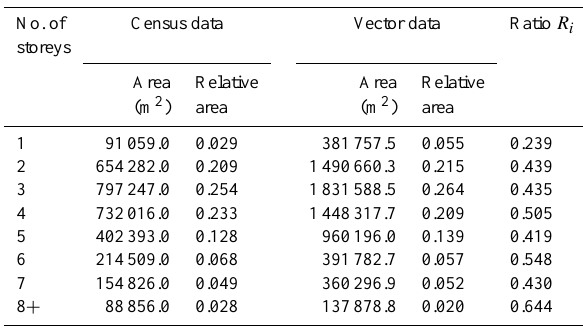
Table 2. Estimated floor areas of the buildings of each height